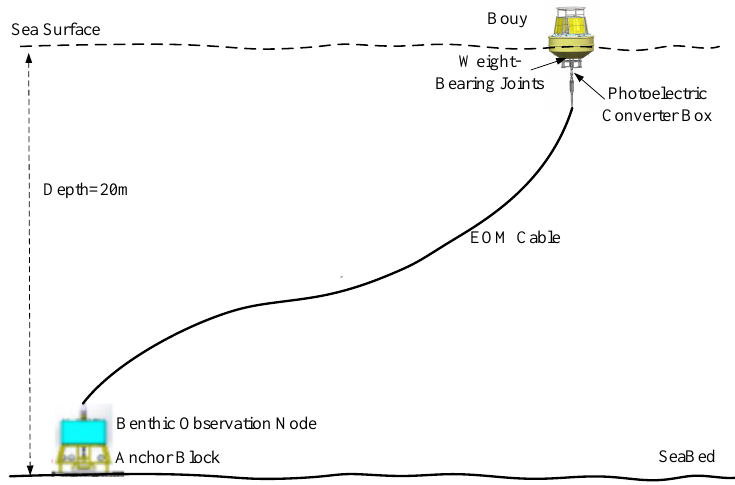
Figure 9. Mooring design of system in 20 m depth with 60 m EOM cable.